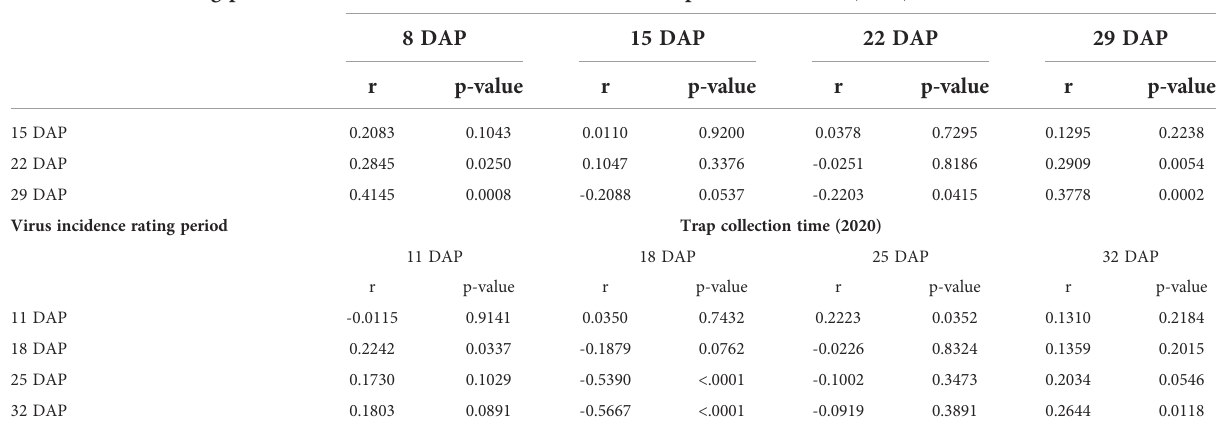
TABLE 2 Correlation matrix of white fl y counts from traps and WTVC incidence in experimental fi eld trials conducted at the University of Georgia Black Shank Farm, Tifton, Georgia, USA in 2019 and 2020. Virus incidence rating